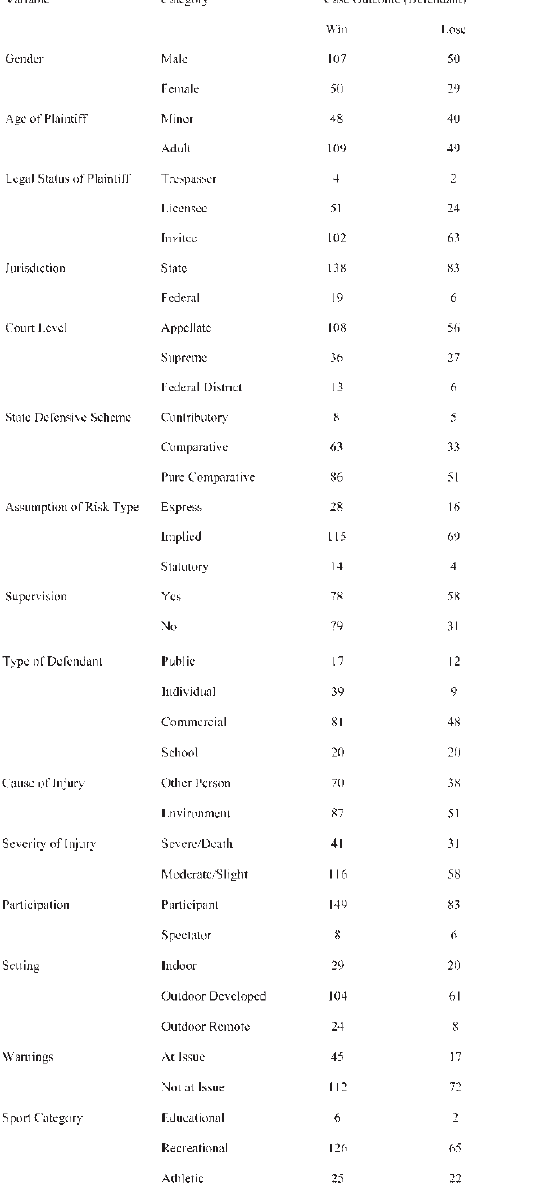
FIGURE 5 CROSS-TABULATION OF CASE OUTCOME WITH CASE VARIABLES